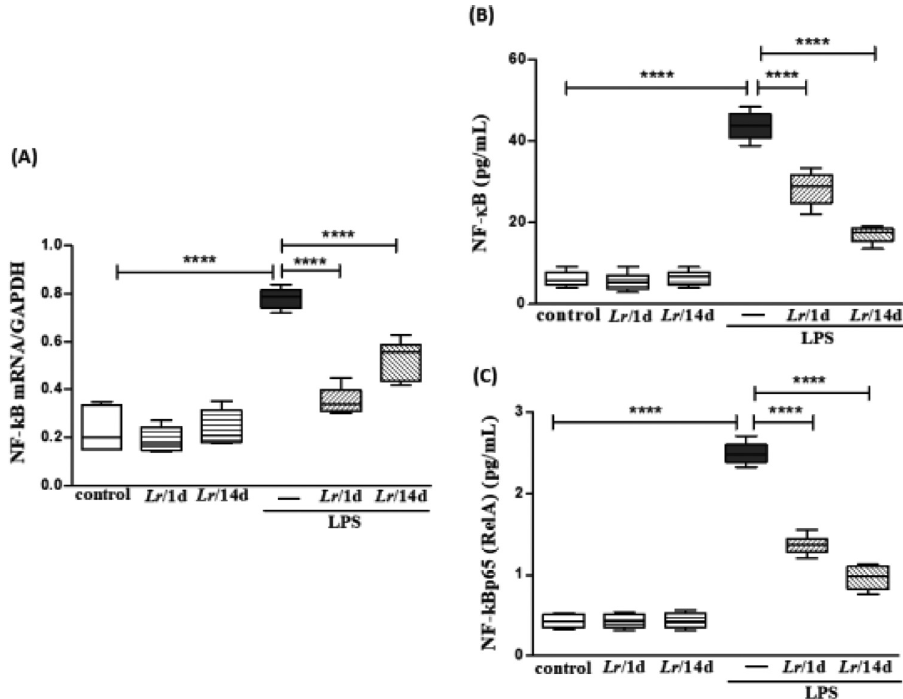
Fig. 11. Gene expression of NF-kB and protein concentration of NF- κ B and NF- κ B p65 (RelA) in lung tissue. The C57Bl/6 mice were treated with Lacticaseibacillus rhamnosus (10 9 CFU of Lr in 300 µ L of PBS, orogastric by gavage) for 14 days or one day, before E. coli LPS instillation (0.5 mg/Kg, intranasal). The mice were eutha- nized 24 h after the LPS, and the homogenate and qPCR were processed according to Materials and Methods. mRNA (11A); NF-kB (11B), and NF-kBp65 (RelA) (11C). The results are expressed as mean ± SEM **** p < 0.0001; *** p < 0.001; ** p < 0.01; * p < 0.05 and ns, non-signi fi cant